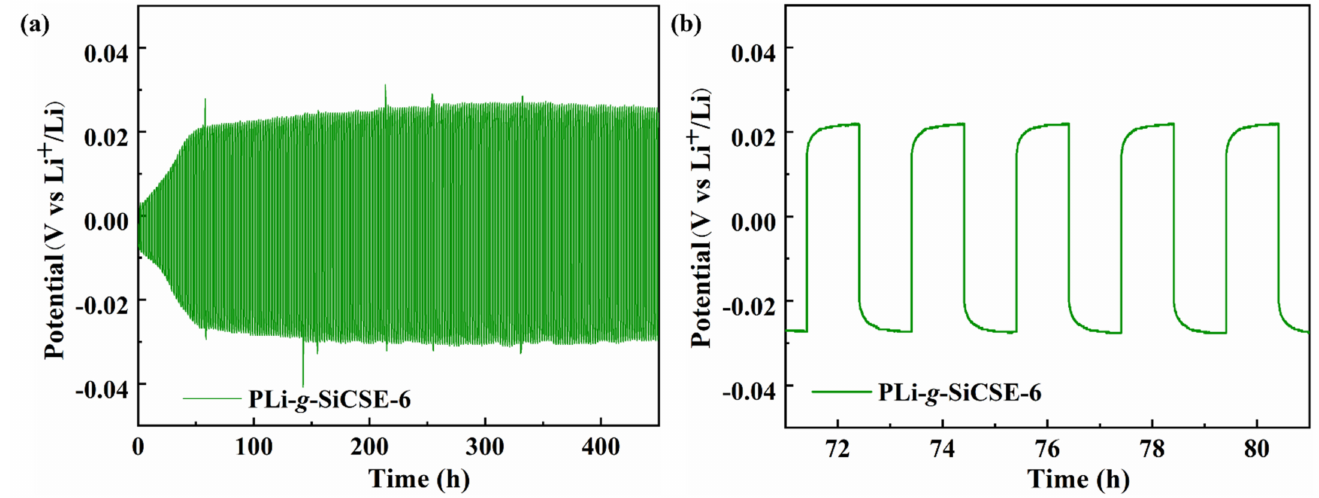
Figure 11. ( a ) Voltage-time curves of Li|PLi- g -SiCSE-6|Li symmetric cell at a constant current density of 0.2 mA · cm − 2 at 60 ◦ C, ( b ) enlarged voltage-time profiles at 70–80 h.